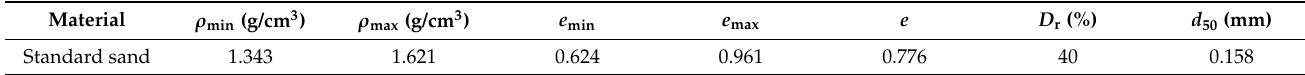
Table 1. Physical properties of the XiFeng standard sand.